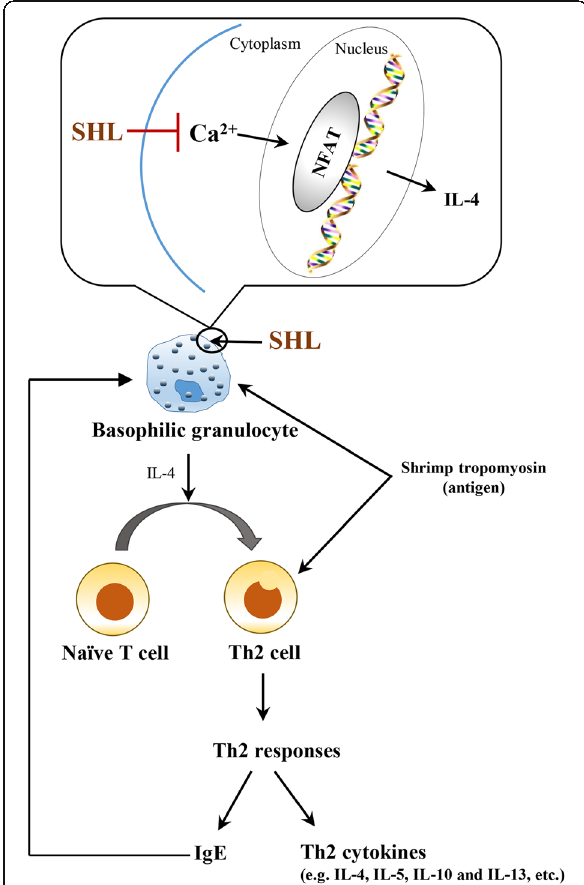
Fig. 4 Schematic diagram depicting how SHL reduces ST-induced Th2